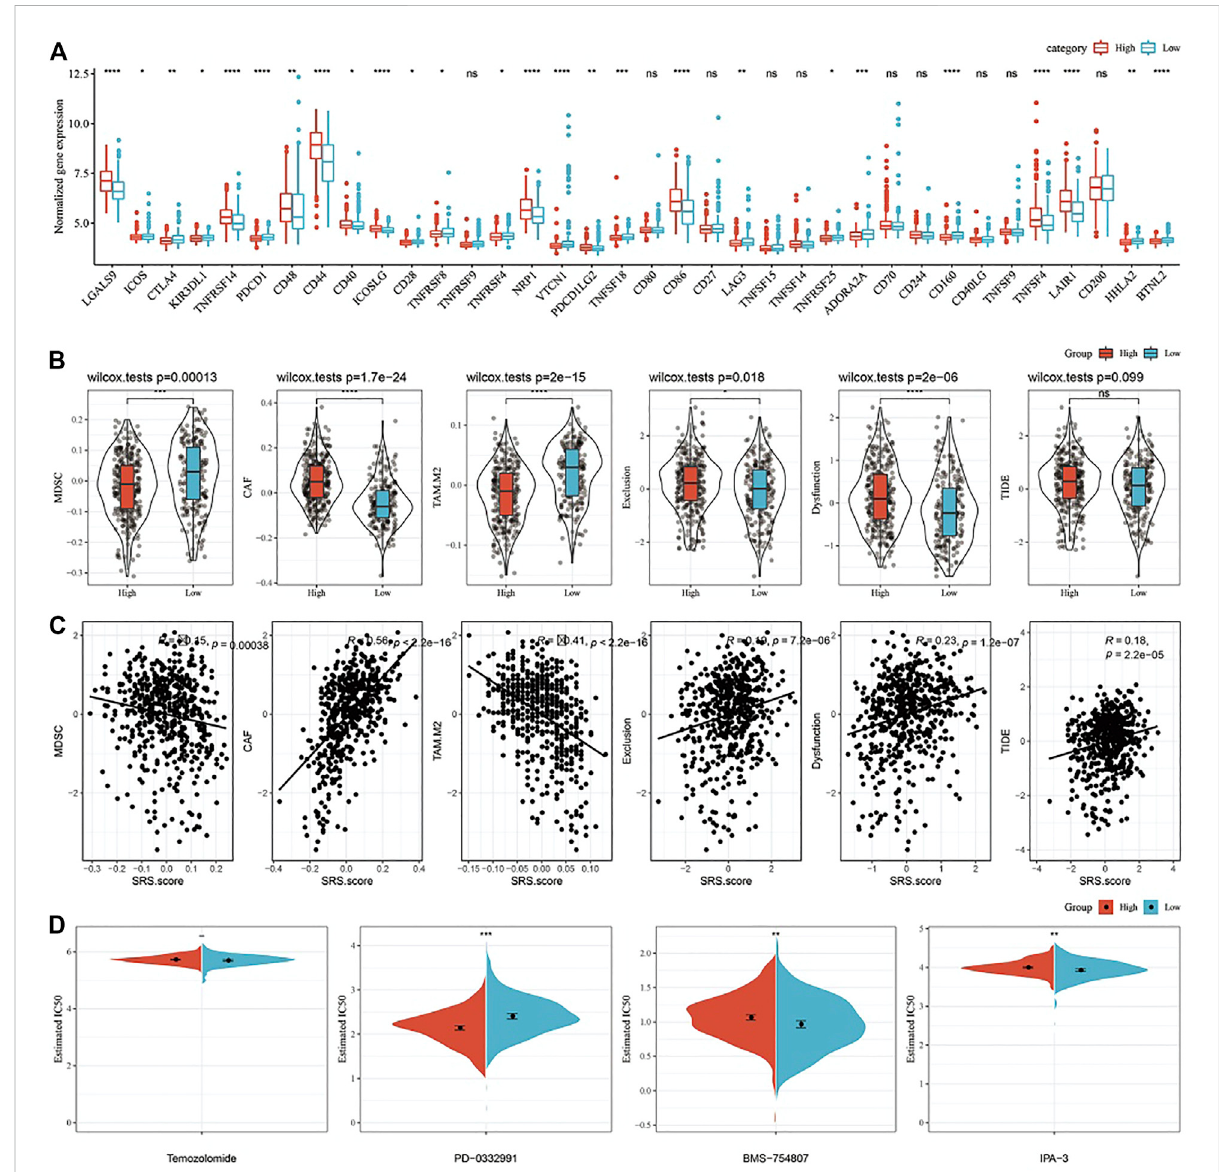
FIGURE 10 Differences in Immune Checkpoints and Drug Susceptibilities in the SRS.score subgroups. (A) Immune checkpoints of differential expression between different groups in TCGA-GBM cohort; (B) The difference of TIDE analysis results between different packets in TCGA-GBM cohort; (C) Correlation analysis between tide results and SRS.score; (D) The box plots of the estimated IC50 for cisplatin, doxorubicin, methotrexate and paclitaxel in TCGA-GBM